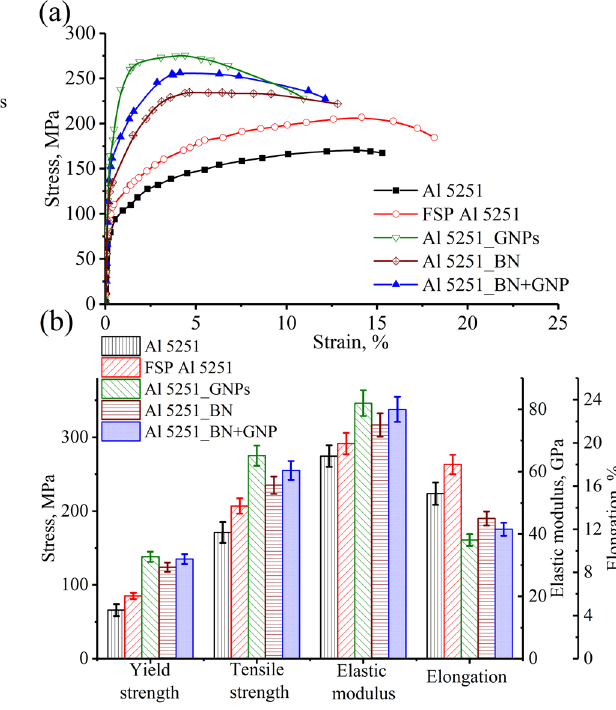
Figure 9: ( a ) True stress - strain curves; ( b ) tensile properties of the investigated hybrid composites.